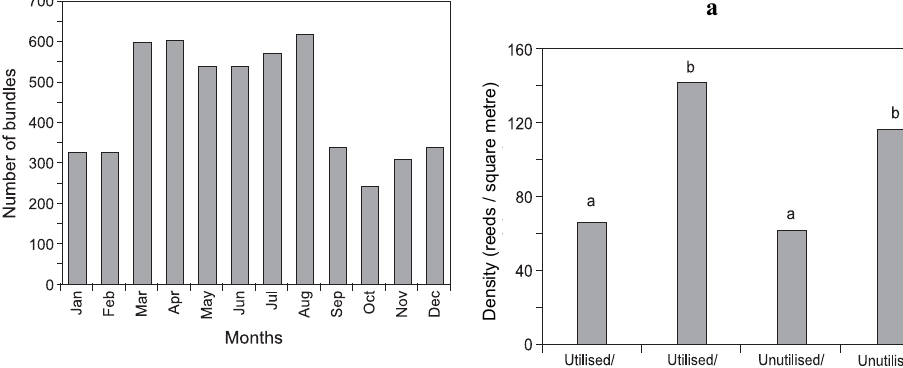
Fig. 2. Monthly reed harvest from the Muzi Swamp in 1999 (Kyle 2000).